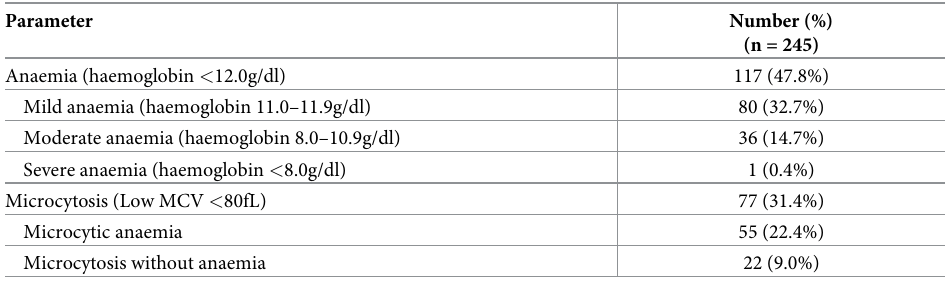
Table 1. Degree of anaemia and microcytosis in study population.